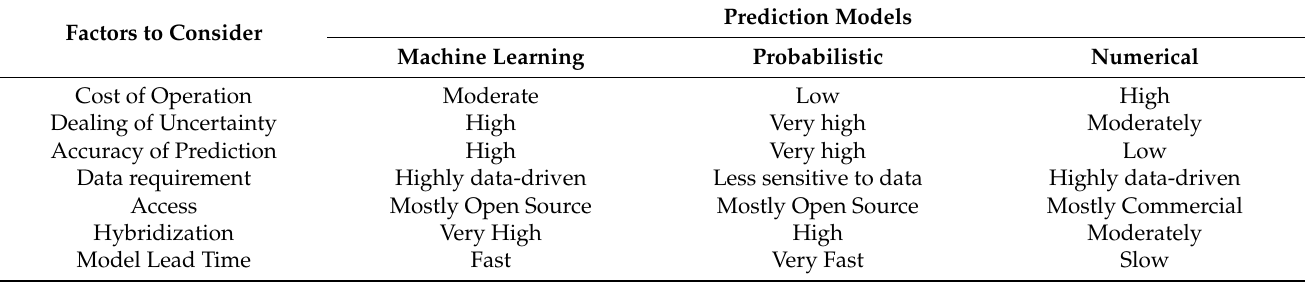
Table A5. Comparison of the Prediction